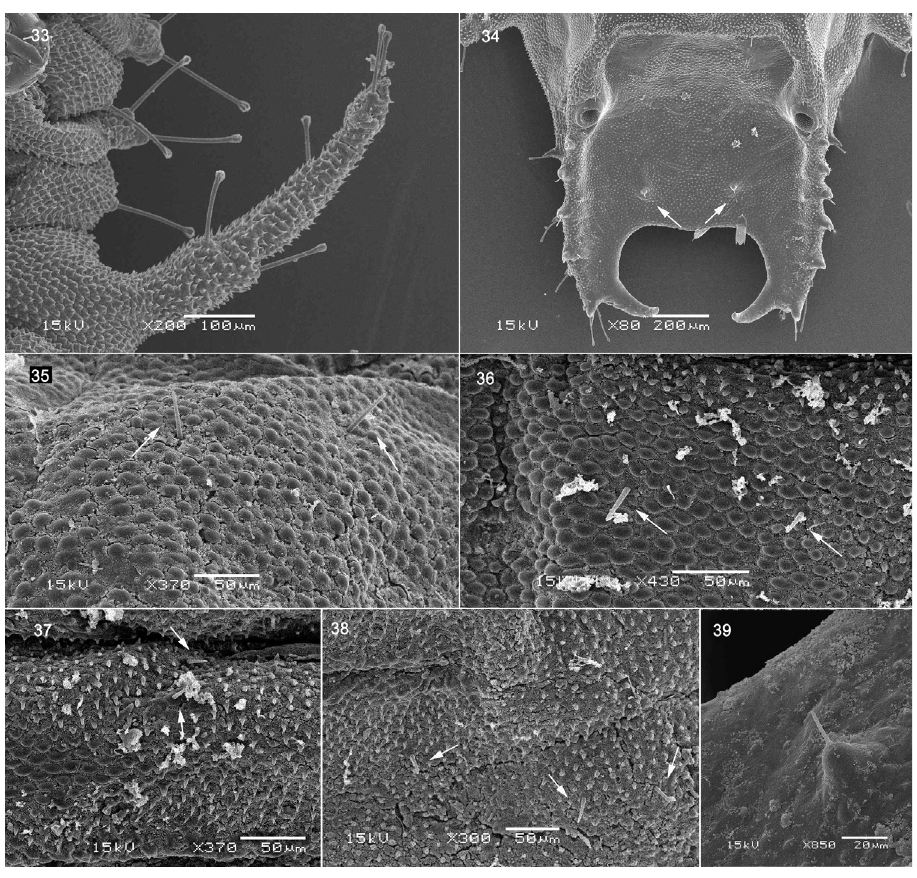
35 setae of prothorax 36 setae of mesothorax 37 , 38 setae of metathorax 39 seta of supra-anal